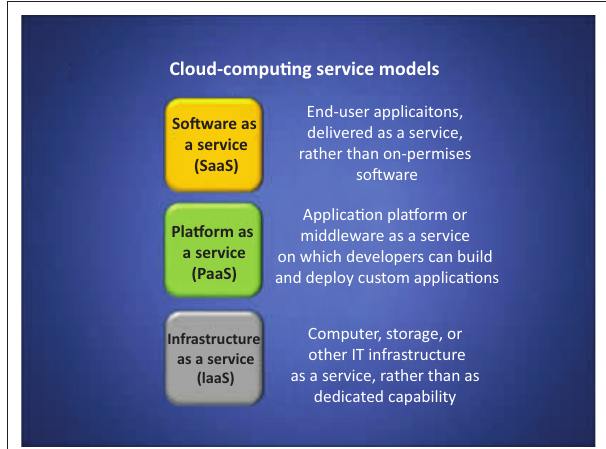
FIGURE 1: Graphic illustration of the four different types of cloud-computing models. FIGURE 2: The three most common cloud-computing service